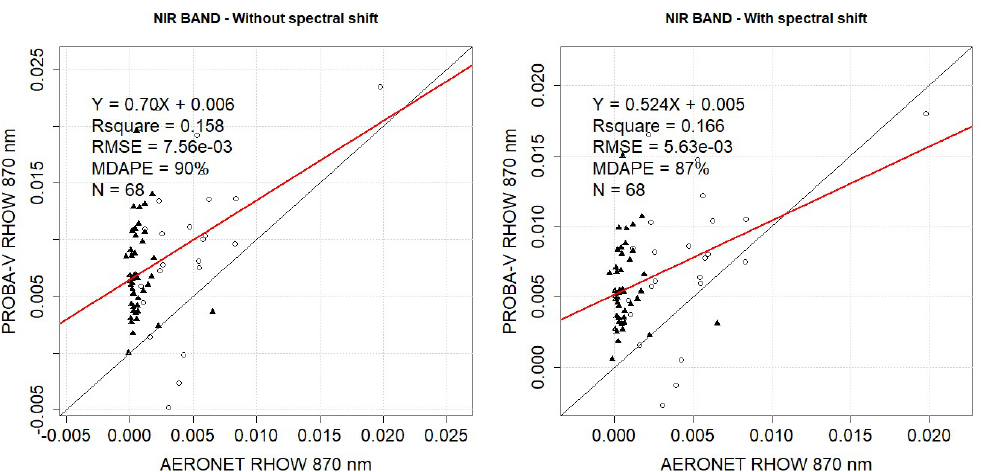
Figure 6. Regression plots of the water leaving reflectance from in situ (AERONET-OC) and from PROBA-V. On the left side, the results without spectral shift of the PROBA-V bands are plotted, while the images on the right shows the results after spectral shift correction. The triangles are results from the Thornton AERONET-OC station, the circles are results from the Zeebrugge-MOW AERONET-OC station. *_conv denotes that a spectral shift correction is applied to the PROBA-V reflectance in order to correct for the spectral response differences between PROBA-V and AERONET-OC. (R² = coefficient of determination; RMSE = Root Mean Square Error; MDAPE = Median Absolute Percentage Error and N = total number observations).